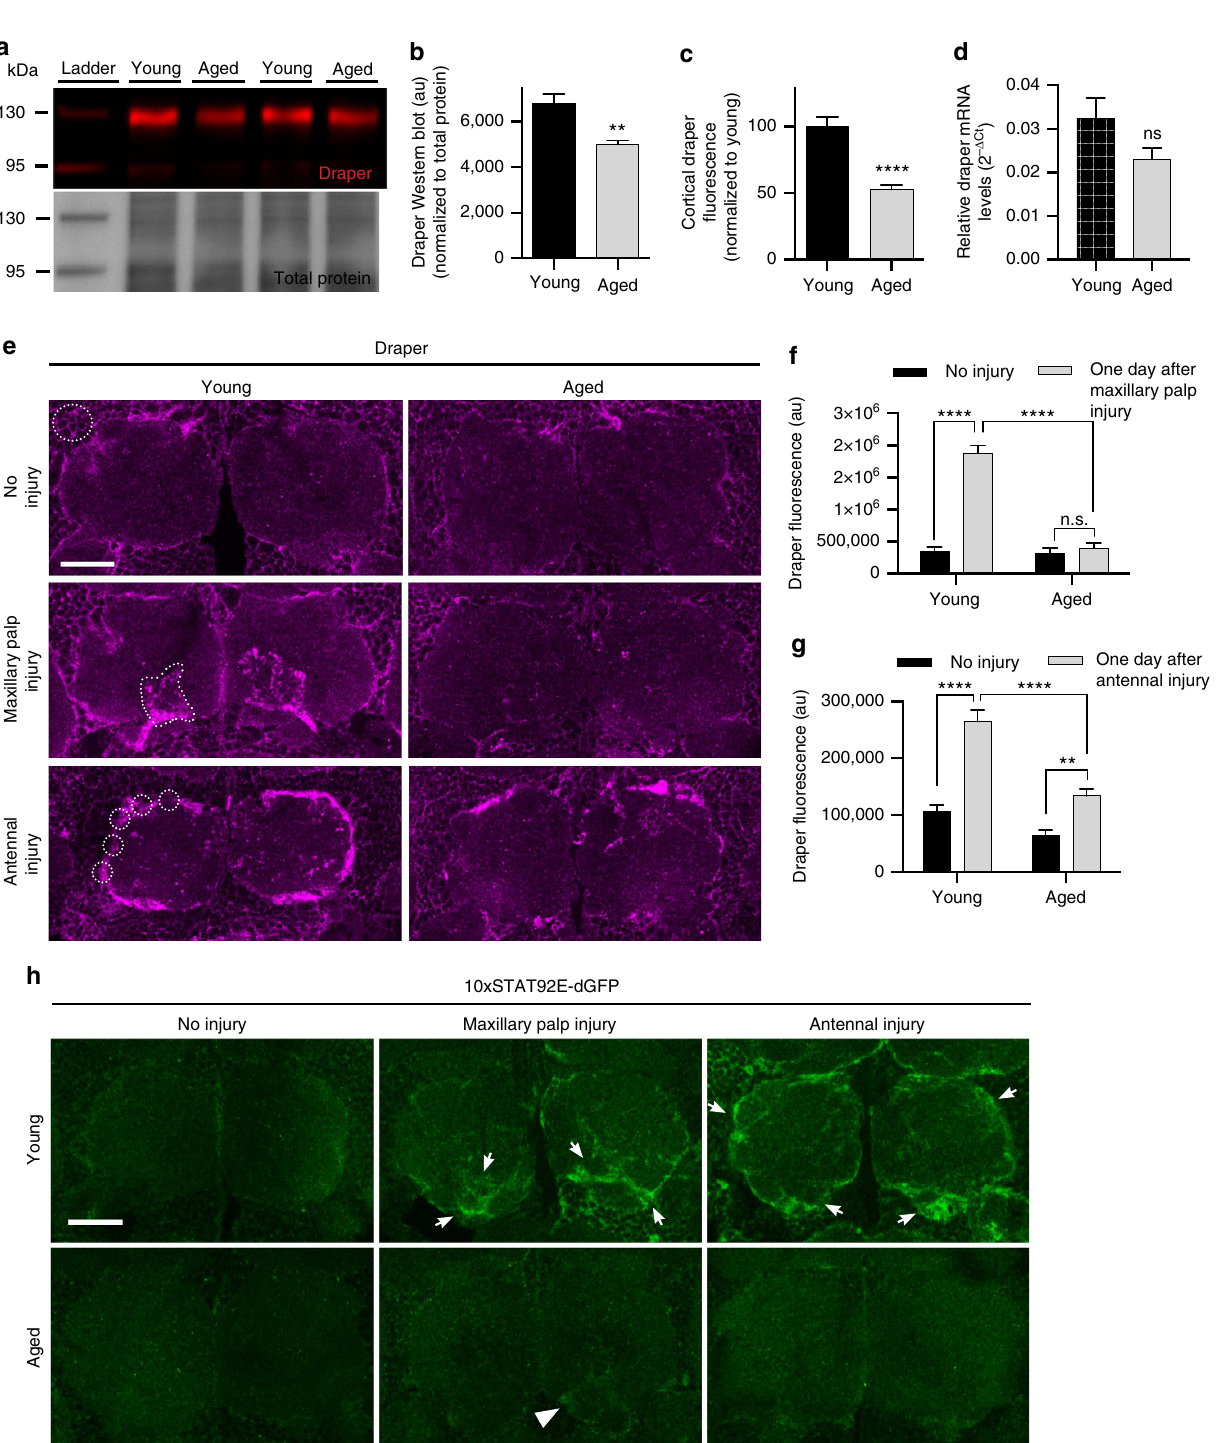
Figure 2 | Axotomy-induced activation of Stat92E and upregulation of Draper decline with age. ( a ) Western blotting with a -Draper (red, top panel) and MemCode general protein stain (bottom panel) of head lysates from young and aged flies. ( b ) Quantification of Draper western blotting. ** P o 0.01, unpaired t -test. ( c ) Quantification of Draper fluorescence in the cortex of young and aged brains. Representative region of interest (ROI) in young uninjured panel in e ; mean ± s.e.m. plotted; **** P o 0.0001, unpaired t -test. ( d ) Quantitative PCR of Draper-I transcript levels in young and aged brains; mean ± s.e.m. plotted, young N ¼ 9, aged N ¼ 10, unpaired t -test. ( e ) Representative single confocal slices of Draper immunostained brains. White dotted outlines on injured images show ROIs used for quantification of Draper in c , f and g . ( f ) Quantification of Draper fluorescence in OR85e maxillary palp glomeruli before and after maxillary nerve injury; N Z 22; mean ± s.e.m. plotted; ** P o 0.01 and **** P o 0.0001. Two-way analysis of variance (ANOVA) with Sidak post-hoc test. ( g ) Quantification of Draper fluorescence in antennal lobe ensheathing glia before and after antennal nerve injury; N Z 22. mean ± s.e.m. plotted; ** P o 0.01 and **** P o 0.0001. Two-way ANOVA with Sidak post hoc test. ( h ) Stat92E-dependent activation of dGFP in the antennal lobe region. Robust reporter activity is observed in young flies 24h after maxillary or antennal nerve injury (arrows) but virtually undetectable in aged animals (arrowhead). Scale bars, 30 m m. Genotypes: a – g : w 1118 . h : 10xStat92E-dGFP/ þ ; NS, not significant; au, arbitrary units. NATURE COMMUNICATIONS|7:12871|DOI: